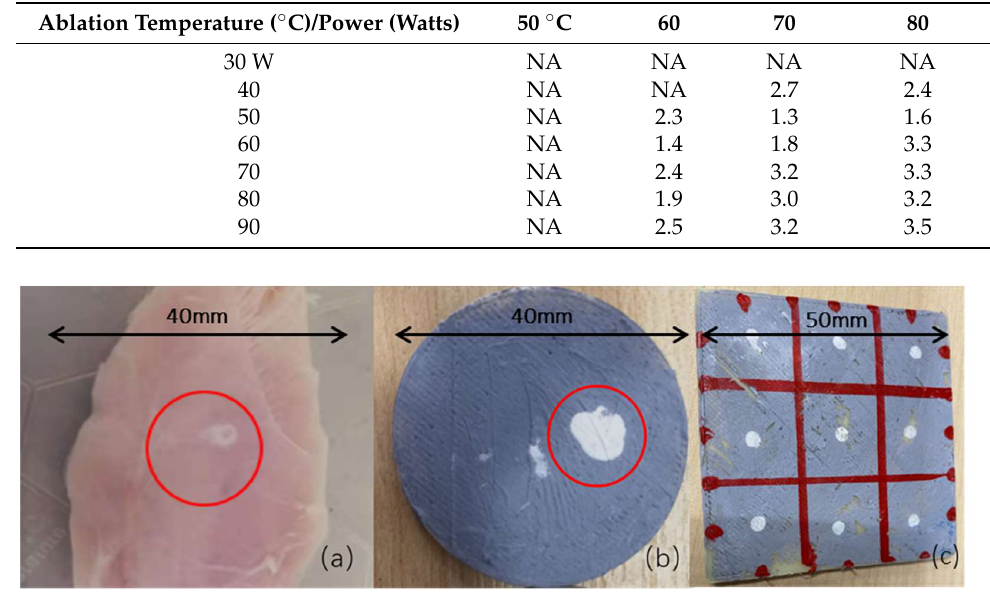
Table 1. Ablation lesion sizes (mm) on thermochromic Layfomm-40 discs using different ablation temperatures and power settings. The ablation duration was 60 s.